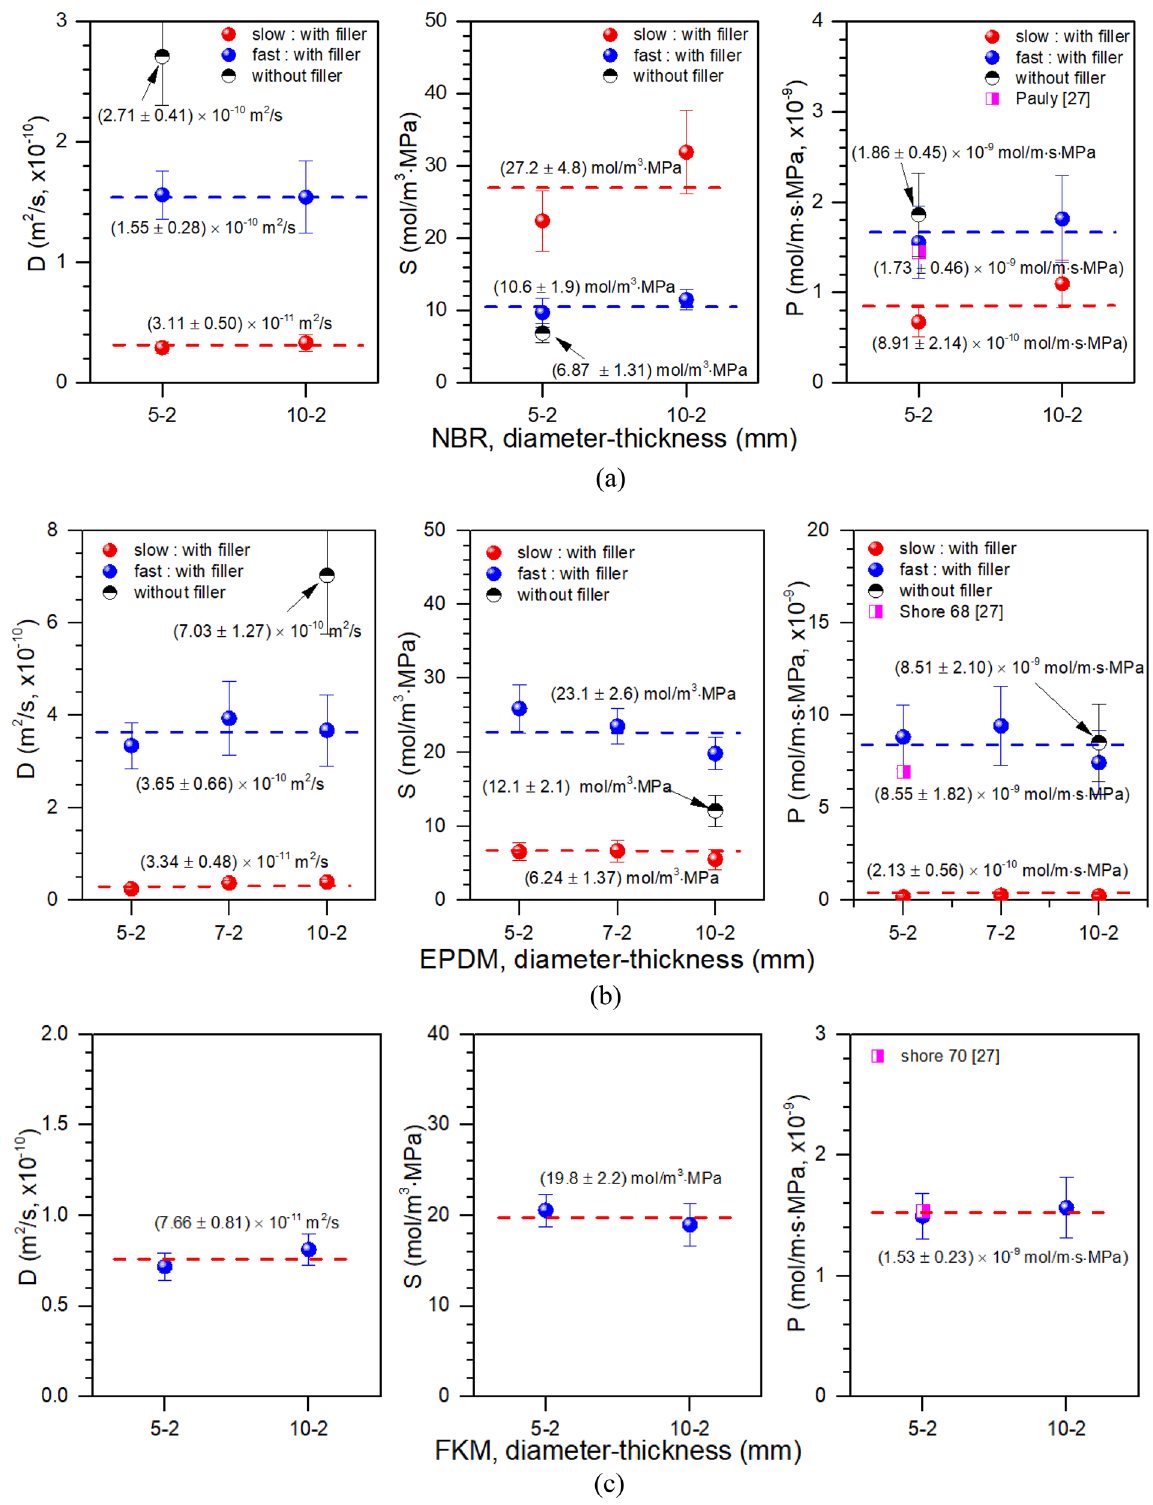
Figure 10. ( a ) Permeation characteristics according to the sample diameter in NBR. Left: diffusivity, middle: solubility, right: permeability. Error bars: expanded uncertainty estimated in a previous work. ( b ) Permeation characteristics according to the sample diameter in EPDM. Left: diffusivity, middle: solubility, right: permeability. Error bars: expanded uncertainty estimated in a previous work. ( c ) Permeation characteristics according to the sample diameter in EPDM. Left: diffusivity, middle: solubility, right: permeability. Error bars: expanded uncertainty estimated in a previous